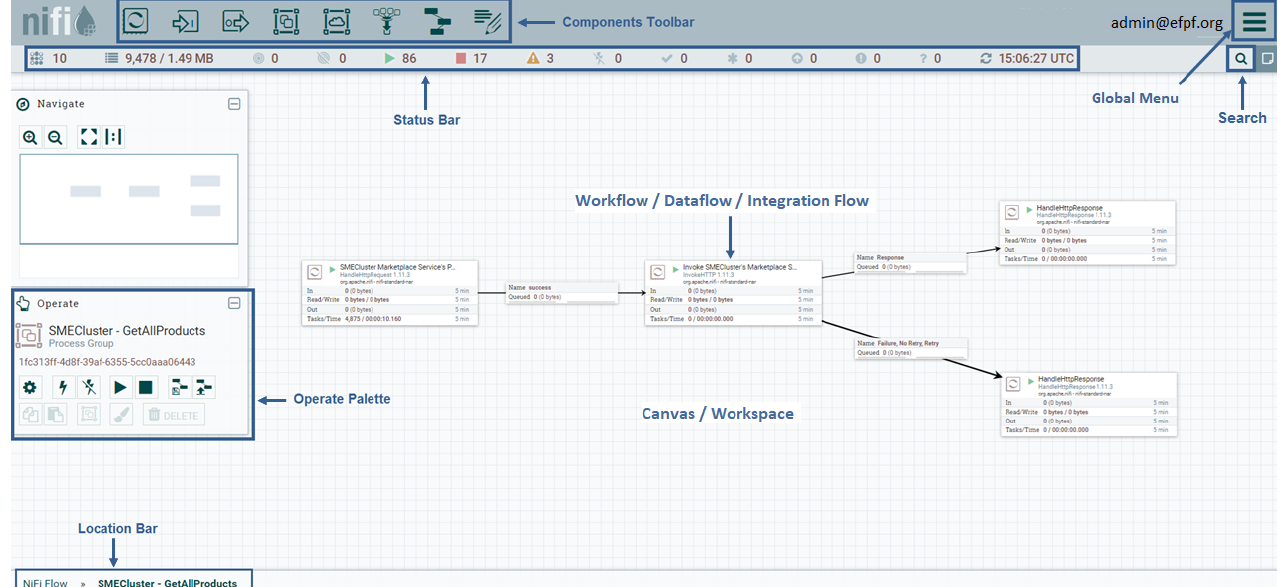
Figure 8. Components of Apache NiFi’s graphical user interface (GUI) and a sample